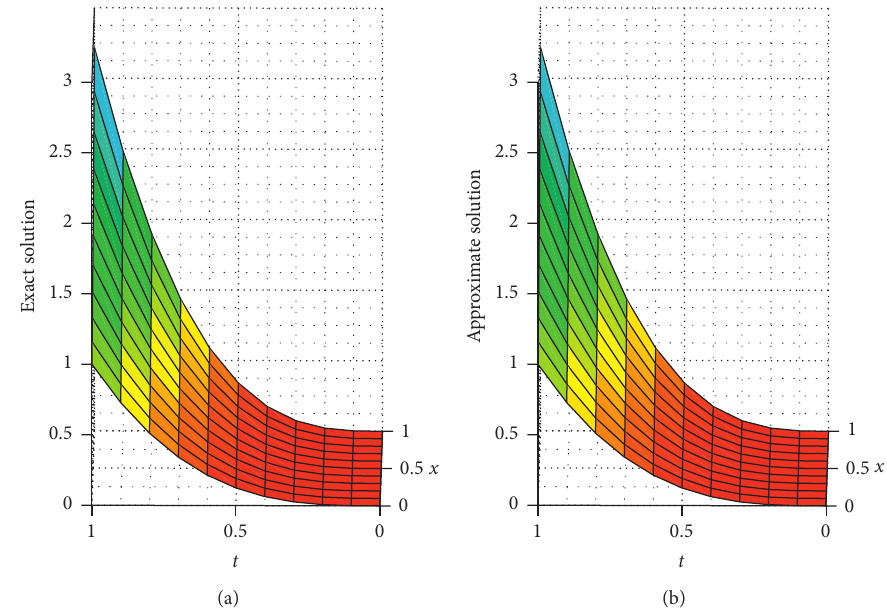
Figure 2: Solution behavior of (a) exact and (b) approximate solutions for Test Problem 4.2.